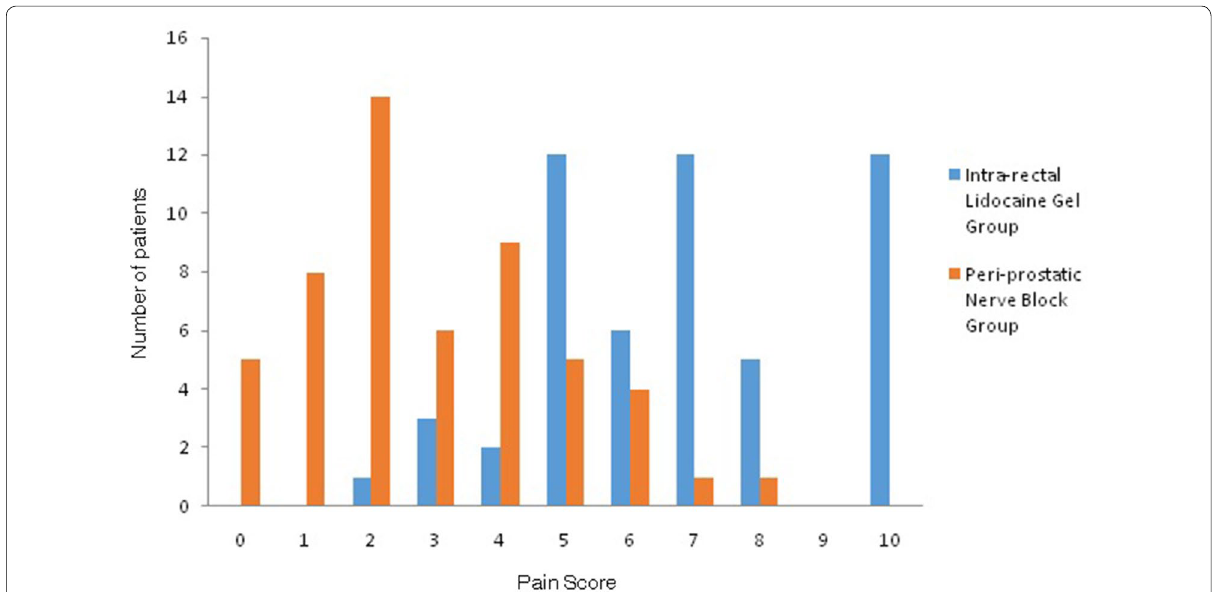
Fig. 3 Pain score during prostate biopsy in the intra-rectal lidocaine gel and peri-prostatic nerve block group